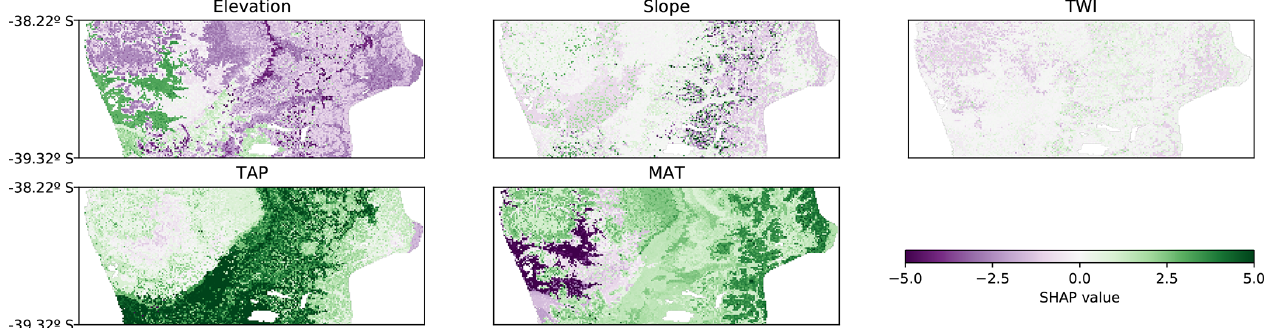
Figure 7. Spatial distribution of SHAP values for each covariate for the tree-like model (RMSE 3.6%). TAP: total annual precipitation; MAT: mean annual temperature; TWI: topographic wetness index.